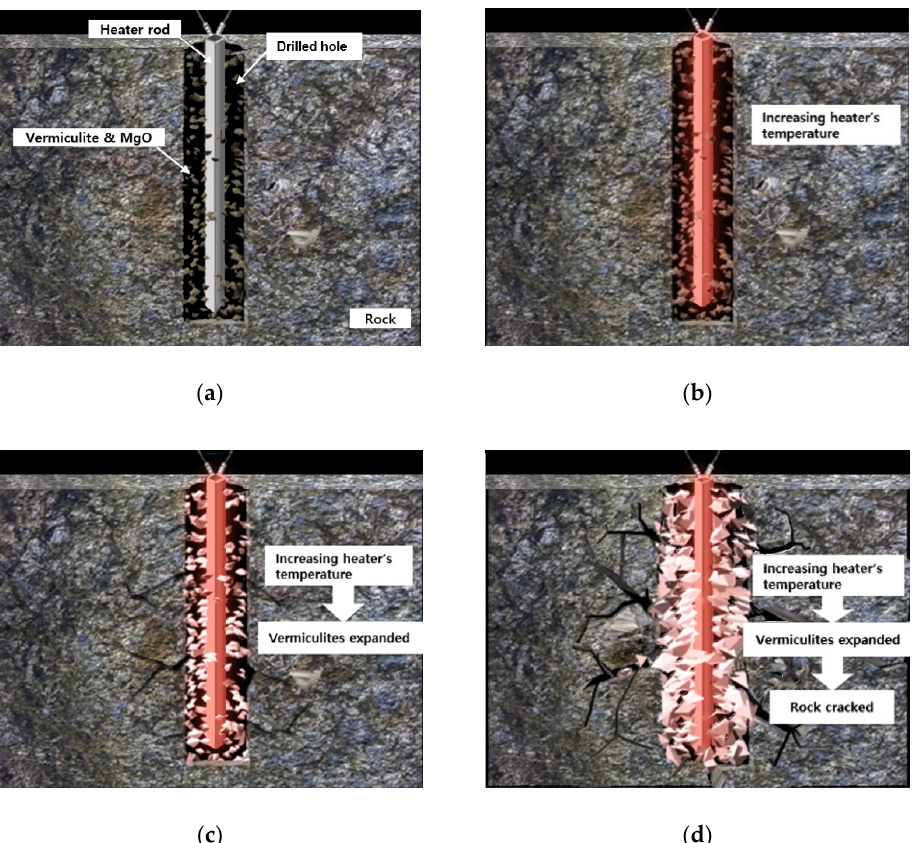
Figure 5. Conceptual drawings of process of the expansion-induced crack method: ( a ) setup of the heating device and materials in the drilled hole; ( b ) increasing the temperature of the heater rod; ( c ) vermiculite expansion; ( d ) cracking of the rock. The drawings are not to scale.